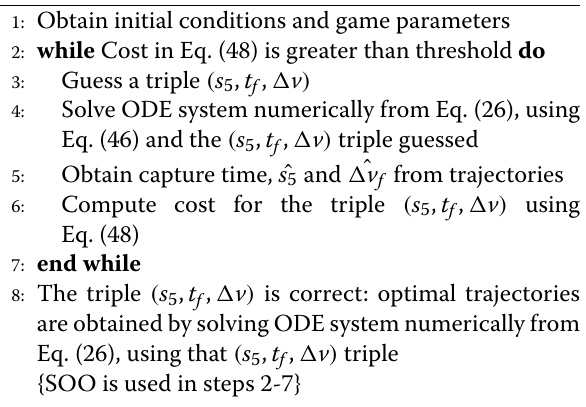
Algorithm 4 Steps for the optimization